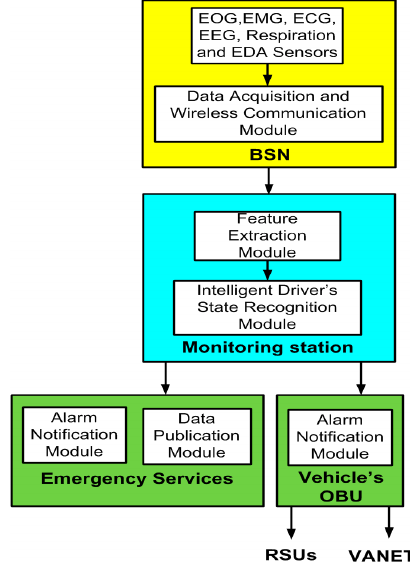
Figure 2. Integrated BSN and VANET architecture.